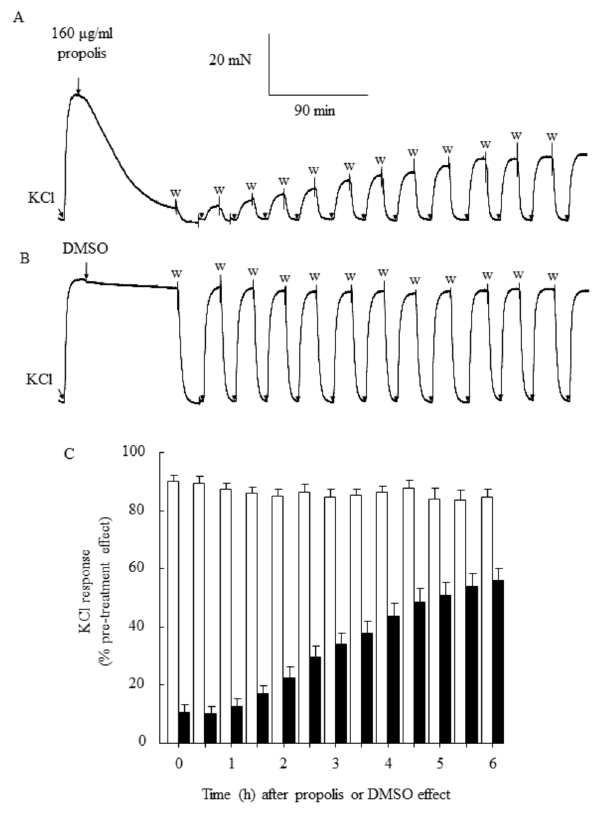
Figure 3. Reversibility of the vasorelaxant response to stingless bee T. carbonaria propolis in 60 mM KCl-precontracted porcine coronary arteries. Propolis (160 µg/ml) caused a near-maximal reduction in coronary artery tone within 90 min of incubation. The contractile response to KCl immediately after washout was markedly lower than the KCl response obtained prior to addition of propolis (A). The KCl response was not blunted in dimethyl sulfoxide (DMSO)-treated tissues (B). The relaxant response to propolis was partially reversed during half-hourly wash-KCl cycles over a 6 hour period (open bars, DMSO-treated tissues; closed bars, propolis-treated tissues (C). W,